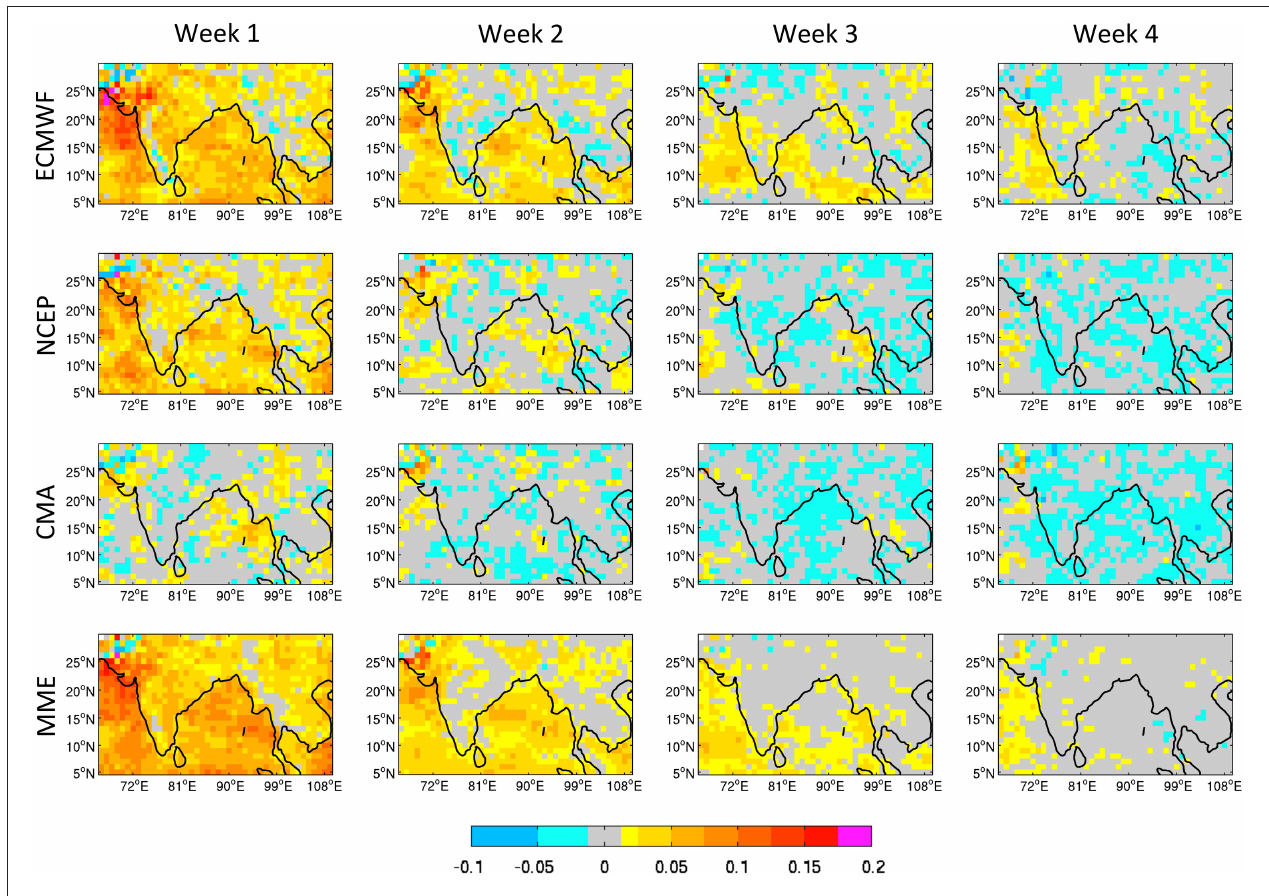
FIGURE 7 | Similar to Figure 5 but for the Asian monsoon